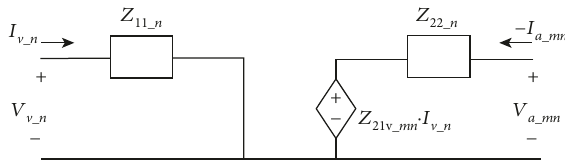
Figure 3: Equivalent circuit for Z parameters of the vector modulator (unilateral